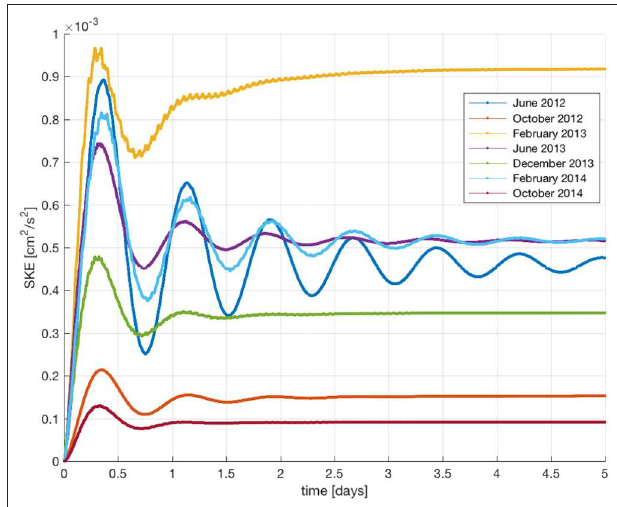
FIGURE 10 | Surface Kinetic Energy time series for each survey during the first 5 days of time integration of the diagnostic calculation. Unit is cm 2 s − 2 .